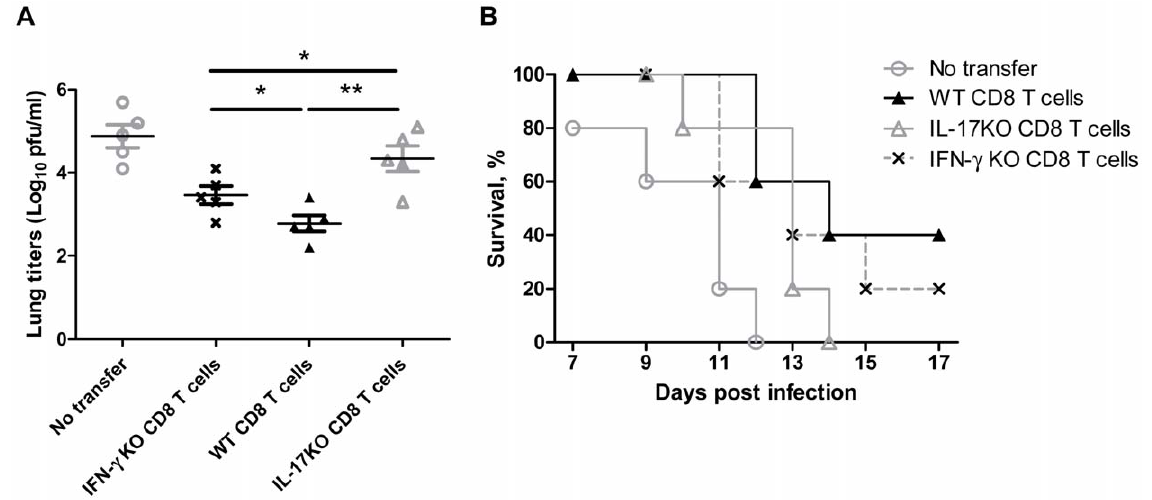
Figure 6. Adoptive transfer of sensitized CD8 + T cells delays the development of virus infection. Each mouse received 5 6 10 6 cells and was then challenged immediately with a lethal dose of H5N1 virus. (A) Viral loads in the lung of mice assayed on day 7 after infection. (B) Survival curves. Data are analyzed from three separate experiments and each had 5 animals. *, p , 0.05. **, p , 0.01. WT CD8 T cells stands for CD8 + T cells from wild type mice immunized with killed vaccine plus PZQ. IFN- c KO CD8 T cells stand for CD8 + T cells from similarly immunized IFN- c KO mice. IL-17KO CD8 T cells stands for CD8 + T cells from similarly immunized IL-17KO mice.